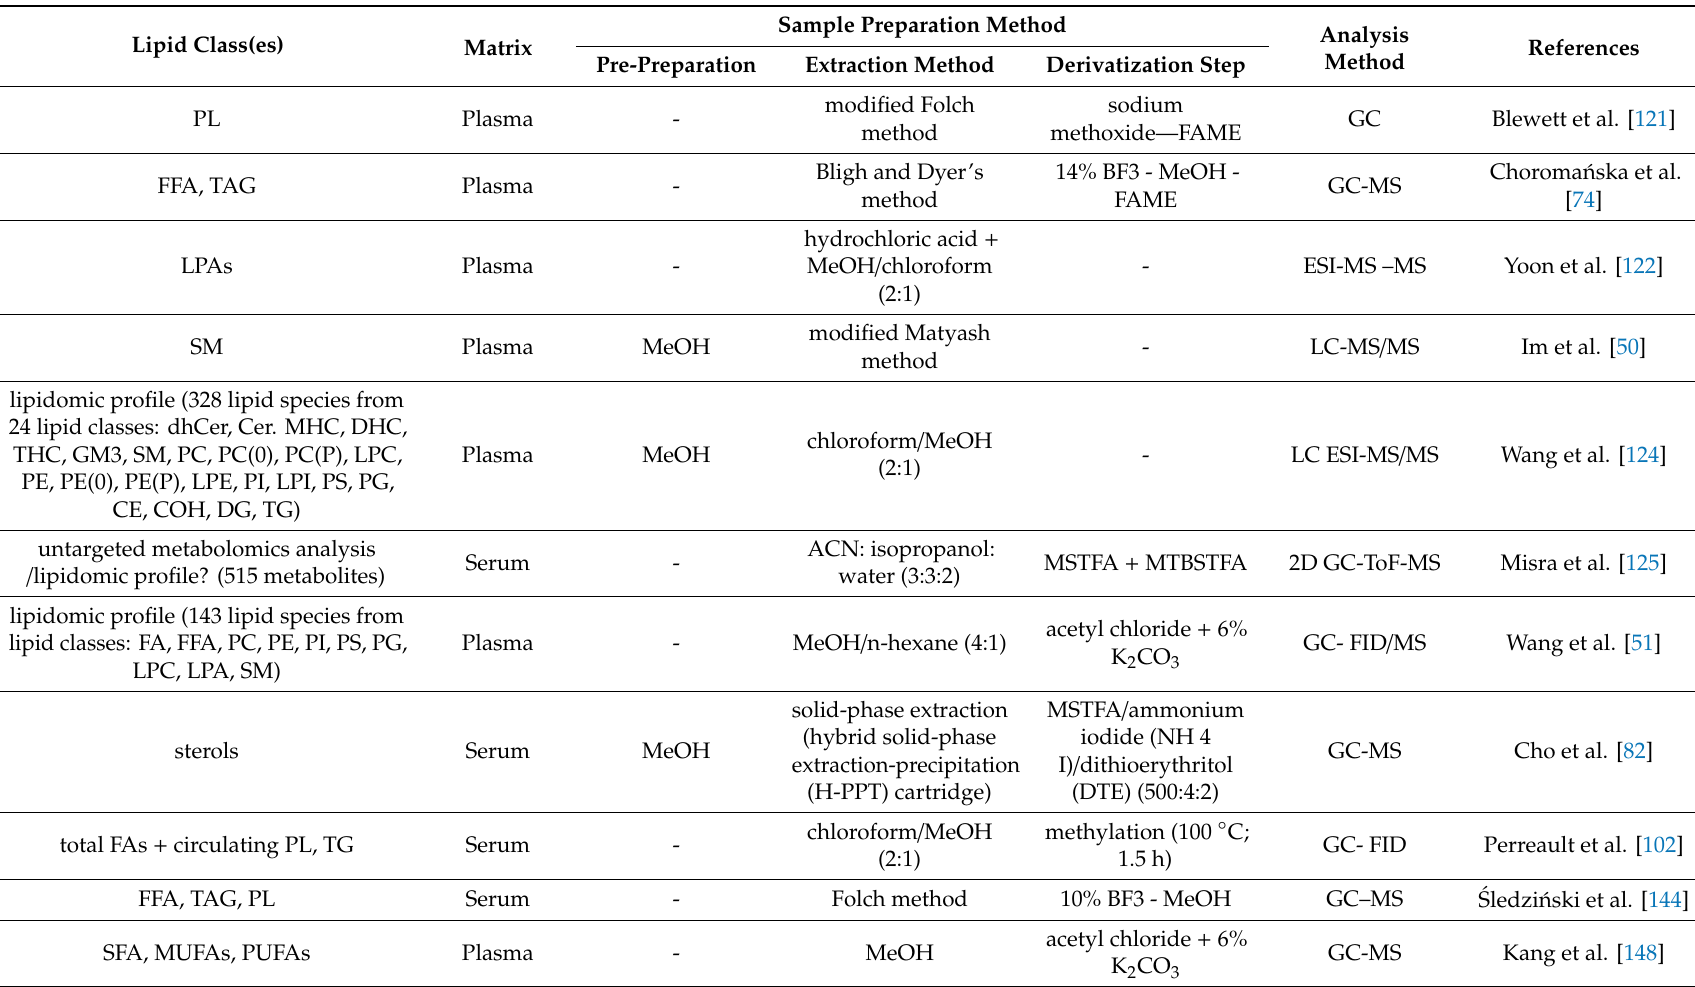
Table 1. Sample preparation methods for lipidomics approaches used in the studies of